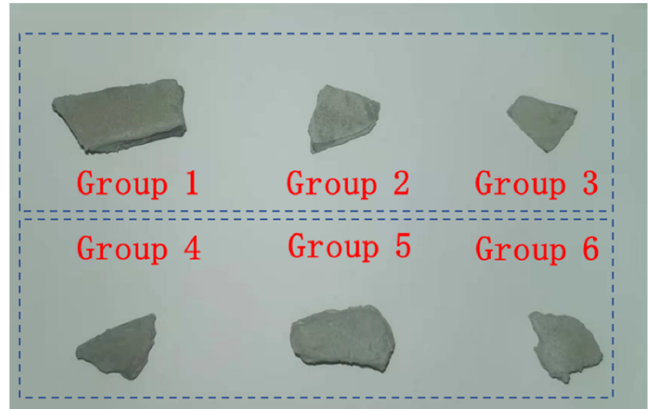
Figure 7. Plastering experiment.